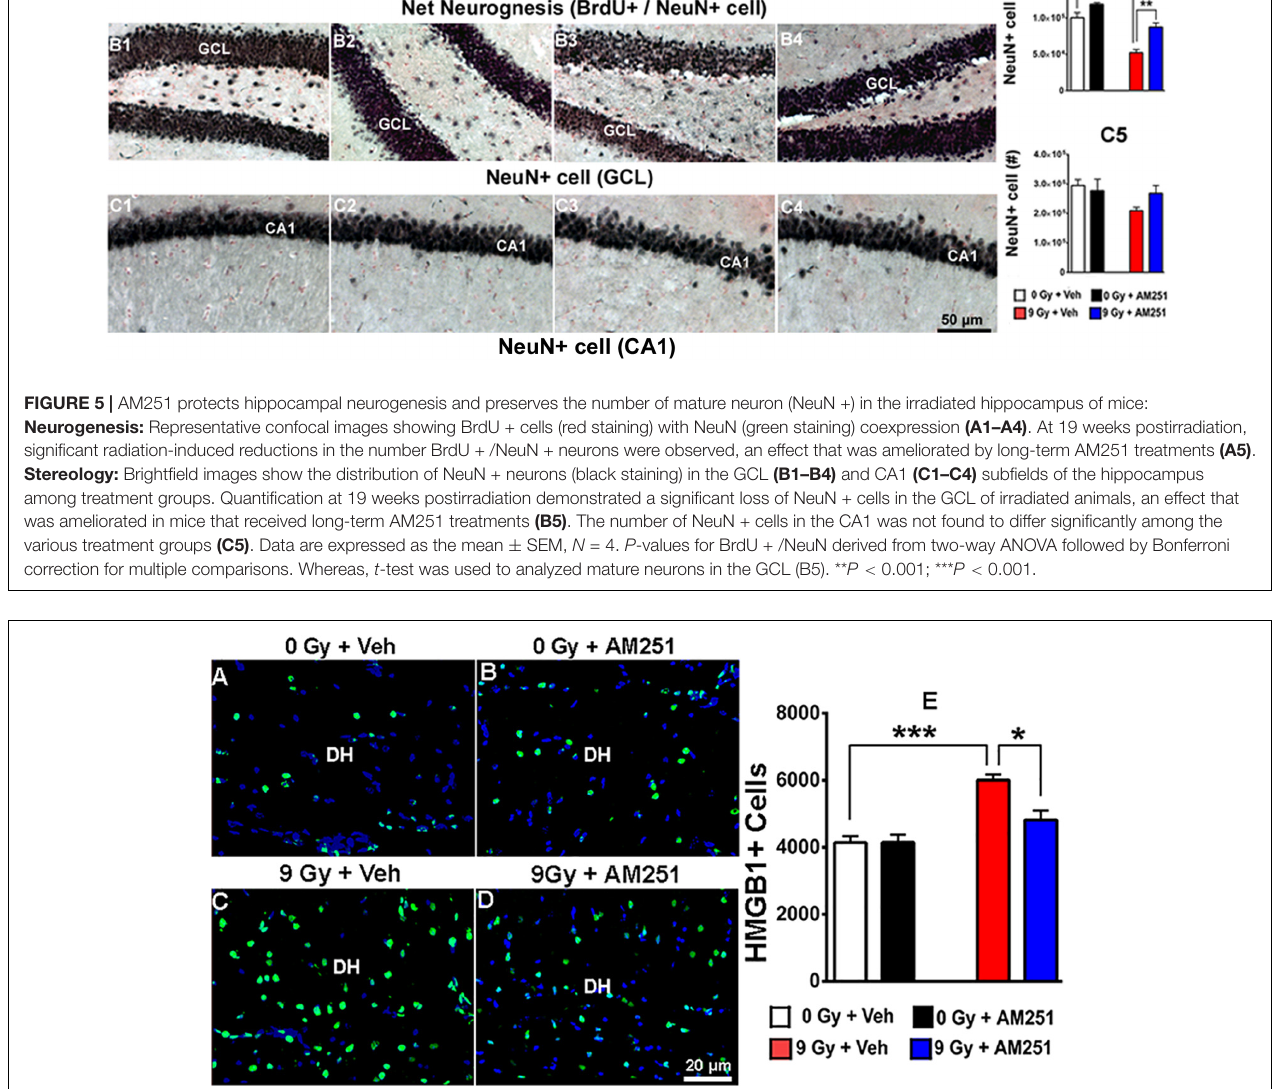
FIGURE 6 | AM251 treatment reduces the expression of HMGB1 in irradiated mice. Representative confocal images of HMGB1 + cells (green staining) in the dentate hilus (DH) of the hippocampus (blue nuclear staining, (A–D) . Quantification at 19 weeks postirradiation demonstrated a significant increase in the number of HMGB1 + cells in irradiated animals, which was attenuated in mice that received long-term AM251 treatments (E) . Data are expressed as the mean ± SEM, N = 4. P -values derived from two-way ANOVA followed by Bonferroni correction for multiple comparisons. * P < 0.05; *** P <